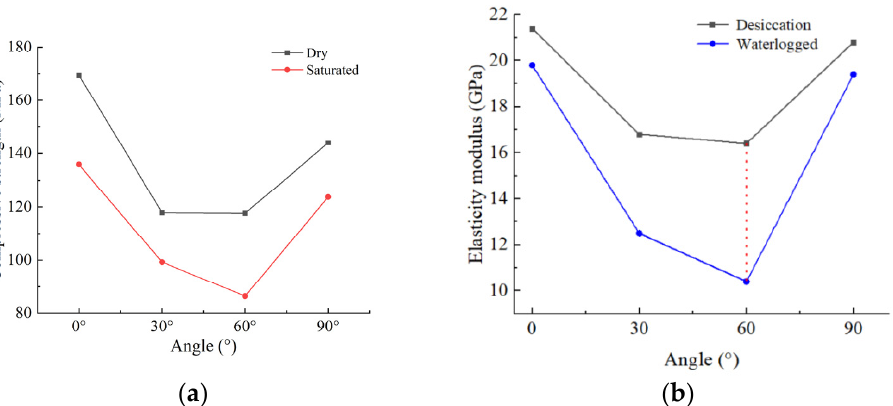
Figure 6. Modulus of elasticity values of samples at different angles in two states: ( a ) Change in compressive strength; ( b ) Change in elasticity modulus of the sample.